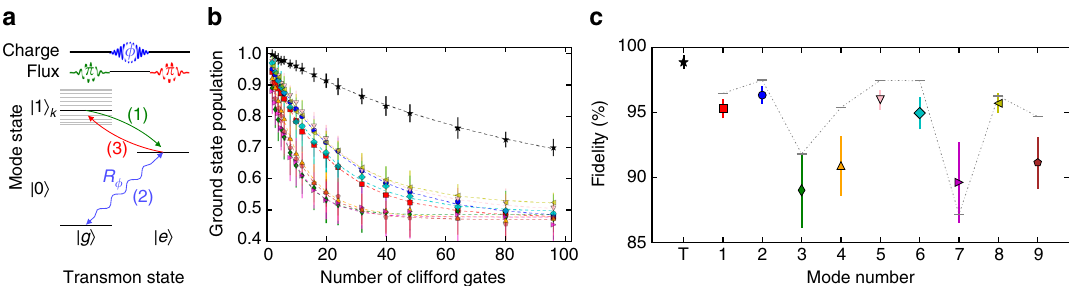
Fig. 3 Single-mode gate protocol and benchmarking. a The sequence for generating arbitrary single-qubit gates of a memory mode: (1) The mode ’ s initial state, consisting of a superposition of 0 and 1 photon Fock states, is swapped to the transmon (initially in its ground state), using a transmon-mode iSWAP (see text). (2) The transmon is rotated by the desired amount ( R ϕ ) via its charge control line. (3) The rotated state is swapped back to the mode, by reversing the iSWAP gate in (1). Segments of this sequence are used to achieve state preparation [steps (2) and (3)] and measurement [steps (1) and (2)] of each mode. b Single-mode RB. We apply sequences of varying numbers of consecutive Clifford gates, then invert each sequence with a unique Clifford gate. We measure the transmon ground-state population after inversion and average over 32 different random sequences, with the standard deviation (s.d.) plotted as error bars for each sequence length. c From fi tting the resulting data, we fi nd single-mode gate fi delities from 89.0 ± 2.9 to 96.3 ± 0.7% and a transmon ( T in the fi gure) gate fi delity of 98.9 ± 1.3%. These are consistent with the expected coherence-limited fi delities, plotted as gray bars